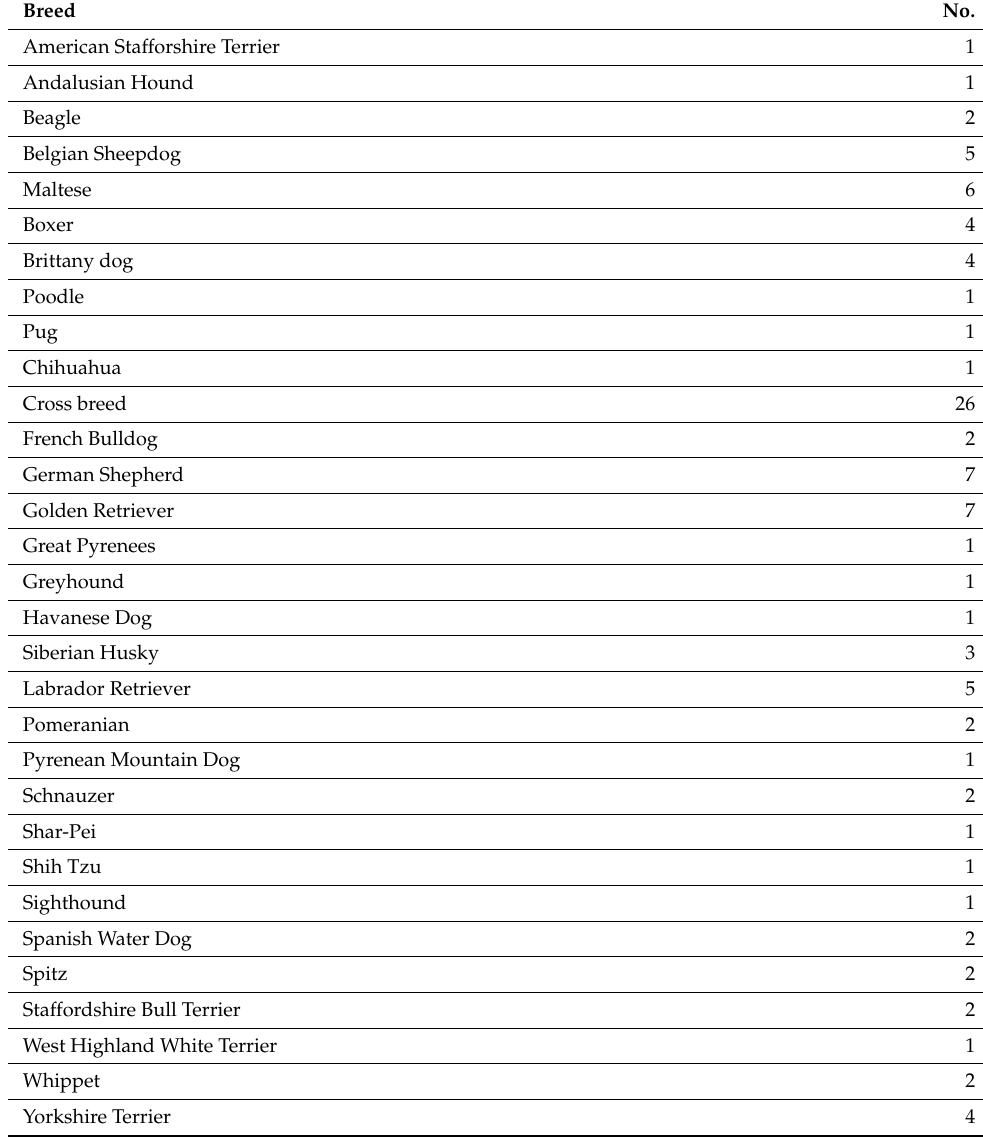
Table 1. Breeds of dogs that participated in the Study